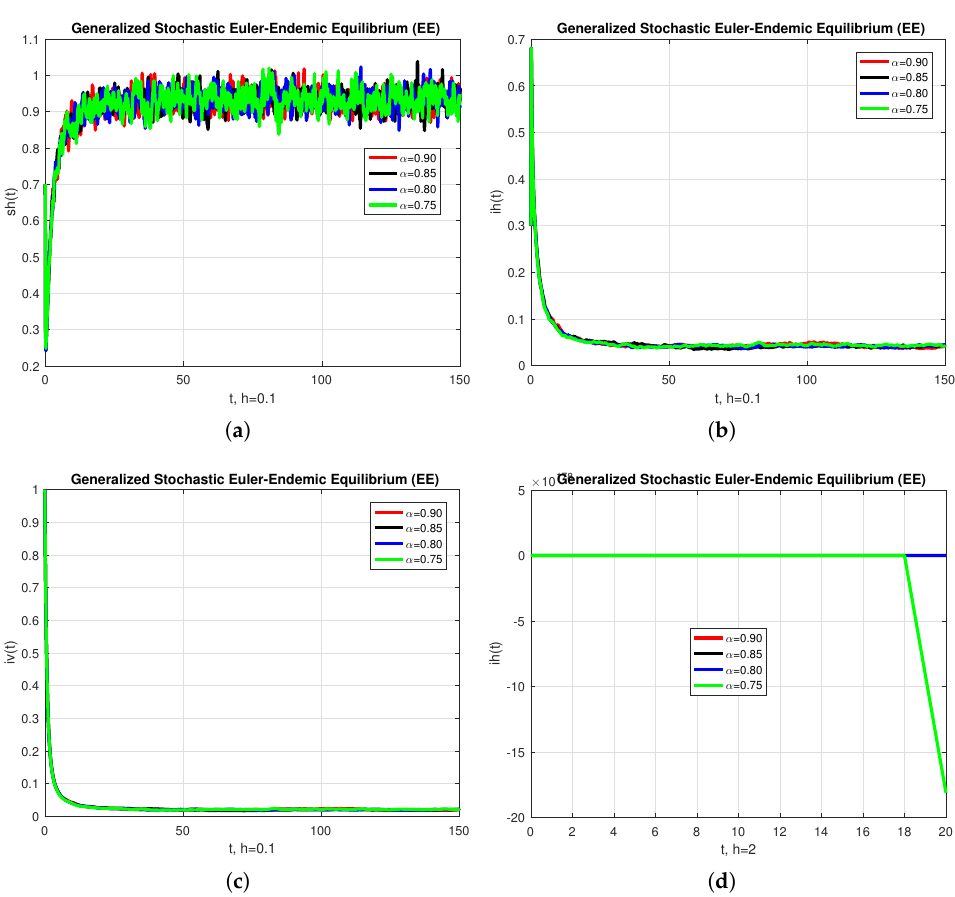
Figure 1. The graphical behavior of each sub-population is presented in the ( a ) numerical solution of s h , ( b ) numerical solution of i h , ( c ) numerical solution of i v and ( d ) numerical solution of i h , with different values of α , using the generalized fractional stochastic Euler